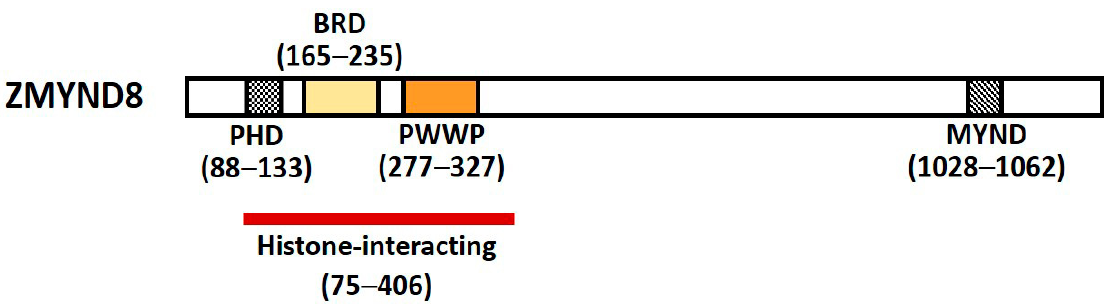
Figure 1. Schematic representation of ZMYND8. ZMYND8 domains include the N-terminal PHD/BRD/PWWP reader cassette and a C-terminal MYND interacting domain. MYND: Myeloid, nervy, and deformed epidermal autoregulatory factor 1; ZMYND8: Zinc finger MYND-type containing 8; PHD: Plant homeodomain; BRD: Bromodomain; PWWP: Pro-Trp-Trp- Pro.